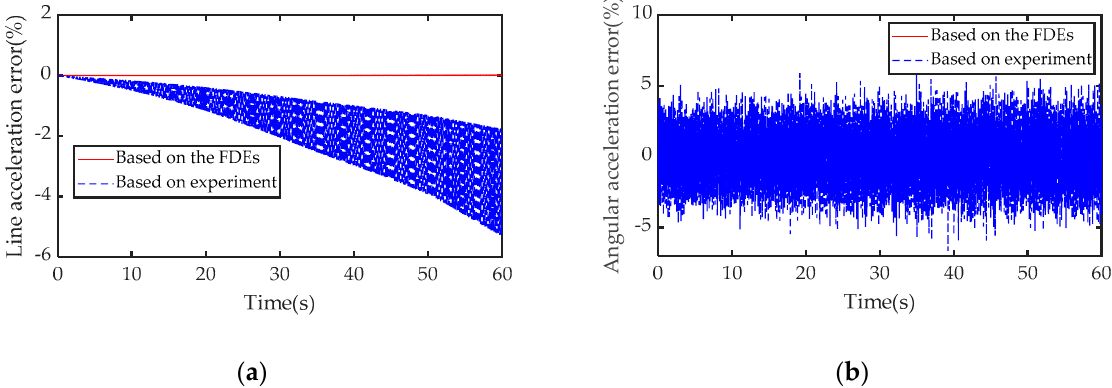
Figure 12. Test error: ( a ) linear acceleration measurement error; ( b ) angular acceleration measurement error.